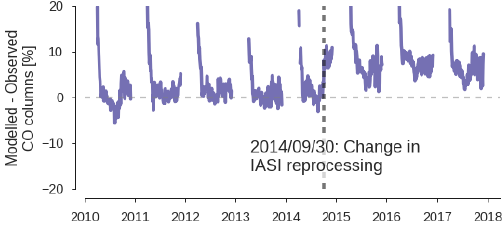
Figure 8. The difference between satellite-retrieved MOPITT CO columns and MOPITT CO columns sampled in a simulation that used CO emissions optimized with IASI-retrieved CO columns, over the 1 ◦ × 1 ◦ South American zoom domain. The difference is quantified as a percentage of the satellite-retrieved CO columns. The date on which IASI switches between two meteorological datasets (30 September 2014) is indicated; on this date, a jump in the difference between simulated and satellite-retrieved MOPITT CO columns